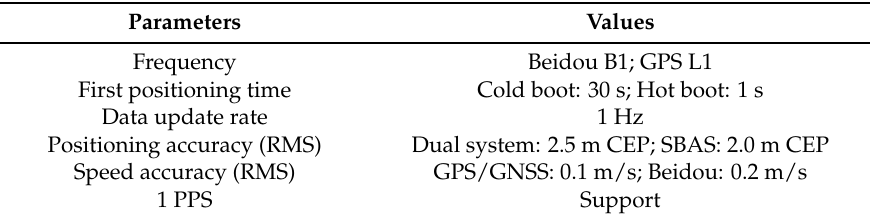
Table 3. Parameters of